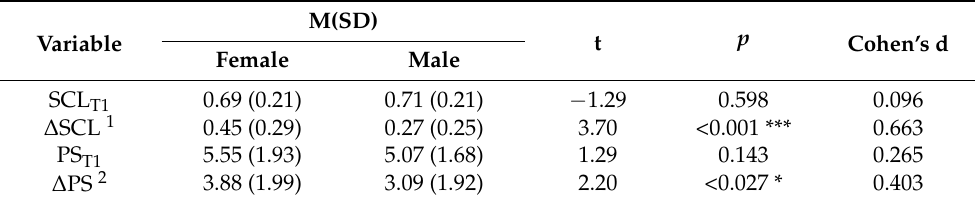
Table 2. Gender difference in skin conductance level (SCL) and perceived stress (PS) reduction after participants were exposed to the same set of environment conditions.